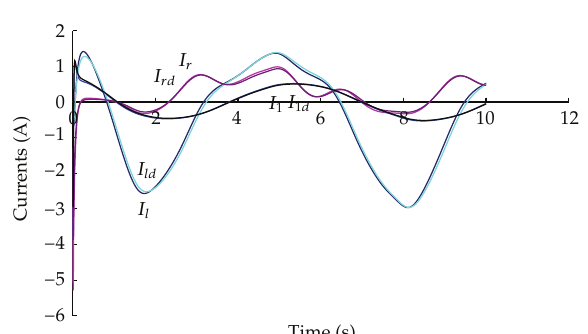
Figure 5: Tracking the desired